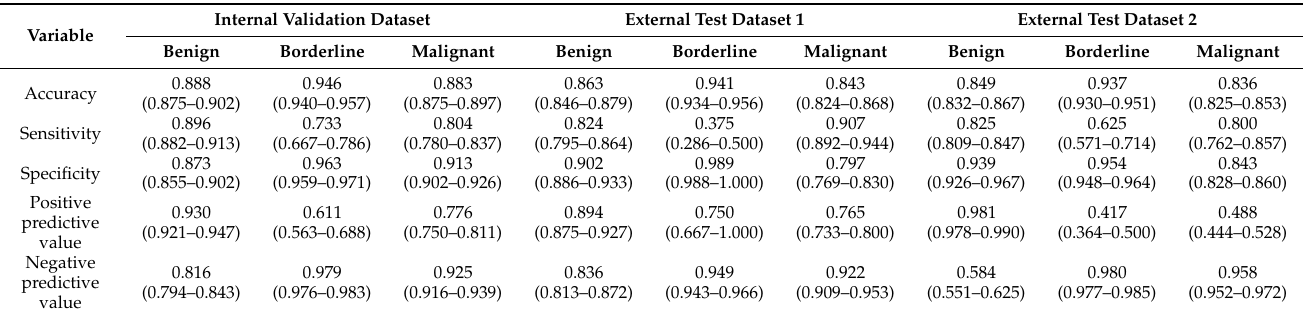
Table 2. Diagnostic performance parameters for the type